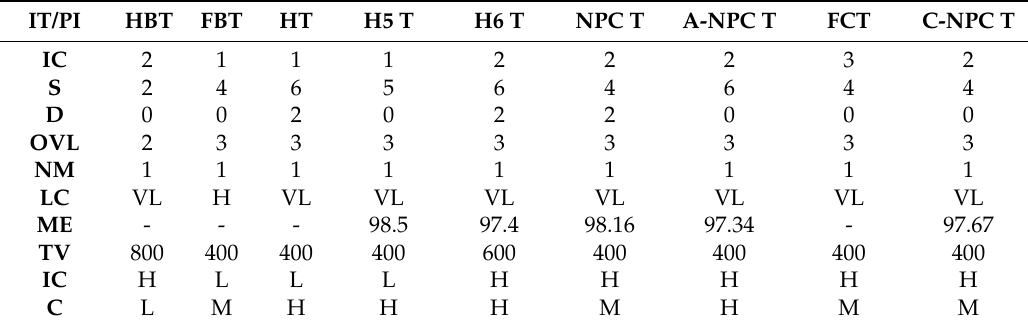
Table 1. Comparative assessment of SPGC transformerless inverter topologies